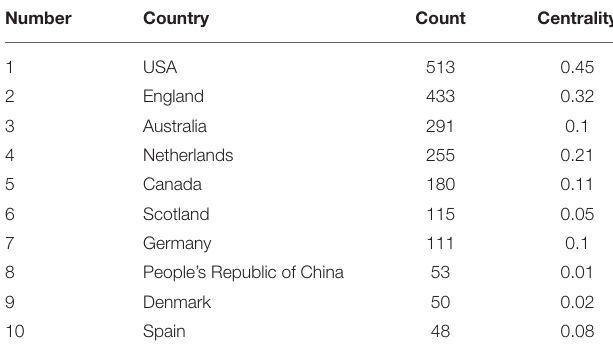
TABLE 2 | The top 10 countries publishing discrete choice experiment (DCE) studies in health